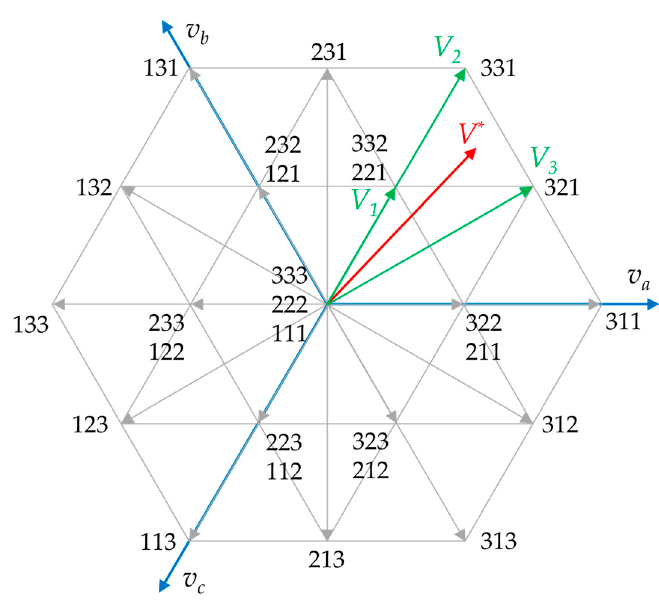
Figure 7. Nearest three vectors selection (NTV − SVM) in a three-phase DC–AC converter.